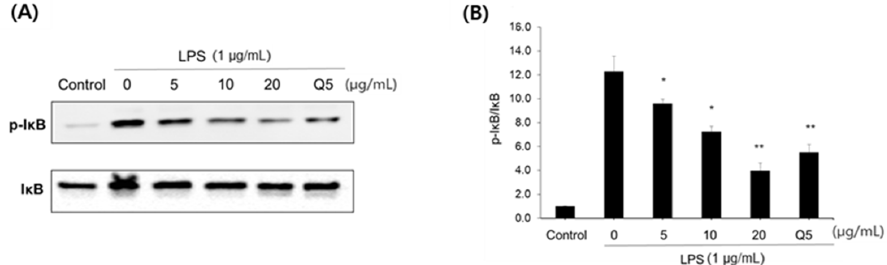
Figure 4. Effect of compound 1 on the IĸB phosphorylation in the NF-κB signaling pathway. ( A ) Western blots of p-IĸB and IĸB and ( B ) quantitative expression of p-IĸB/IĸB. All data are presented as the mean ± SEM ( n = 3). Quercetin (Q5, 5 μ g/mL) was used as the positive control. * p < 0.05 and ** p < 0.01 indicate significant differences compared to the LPS control group.